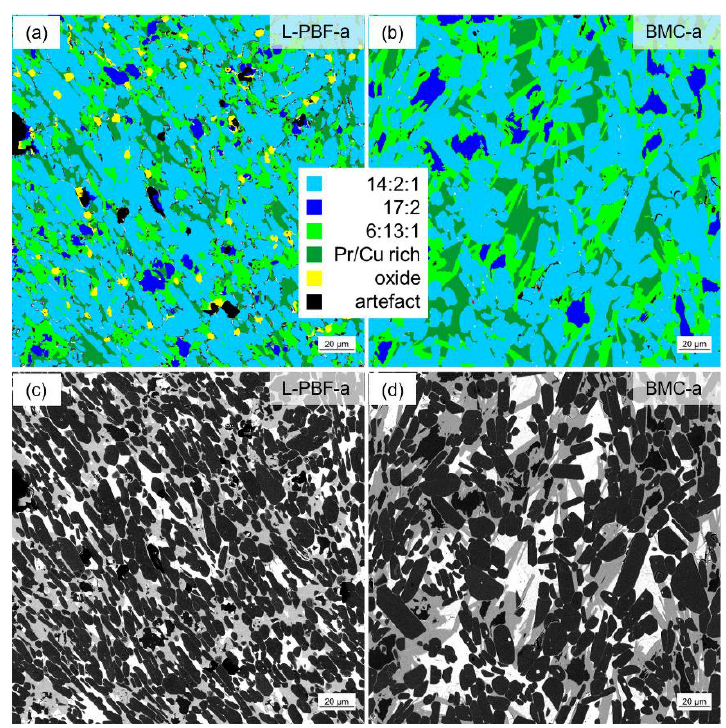
Figure 9. Quantitative image analysis for L-PBF-a in comparison with BCM-a : ( a ) Quantitative image analysis L-PBF-a (false color representation). ( b ) Quantitative image analysis BMC-a (false color representation). ( c ) SEM image used for quantitative image analysis L-PBF-a . ( d ) SEM image used for quantitative image analysis BMC-a . Both contain similar volume fractions of the 14:2:1 phase, Pr-rich phase and 17:2 phase. BMC-a contains slightly larger amounts of the 13:6:1 phase. L-PBF-a contains an additional 3% RE oxides.